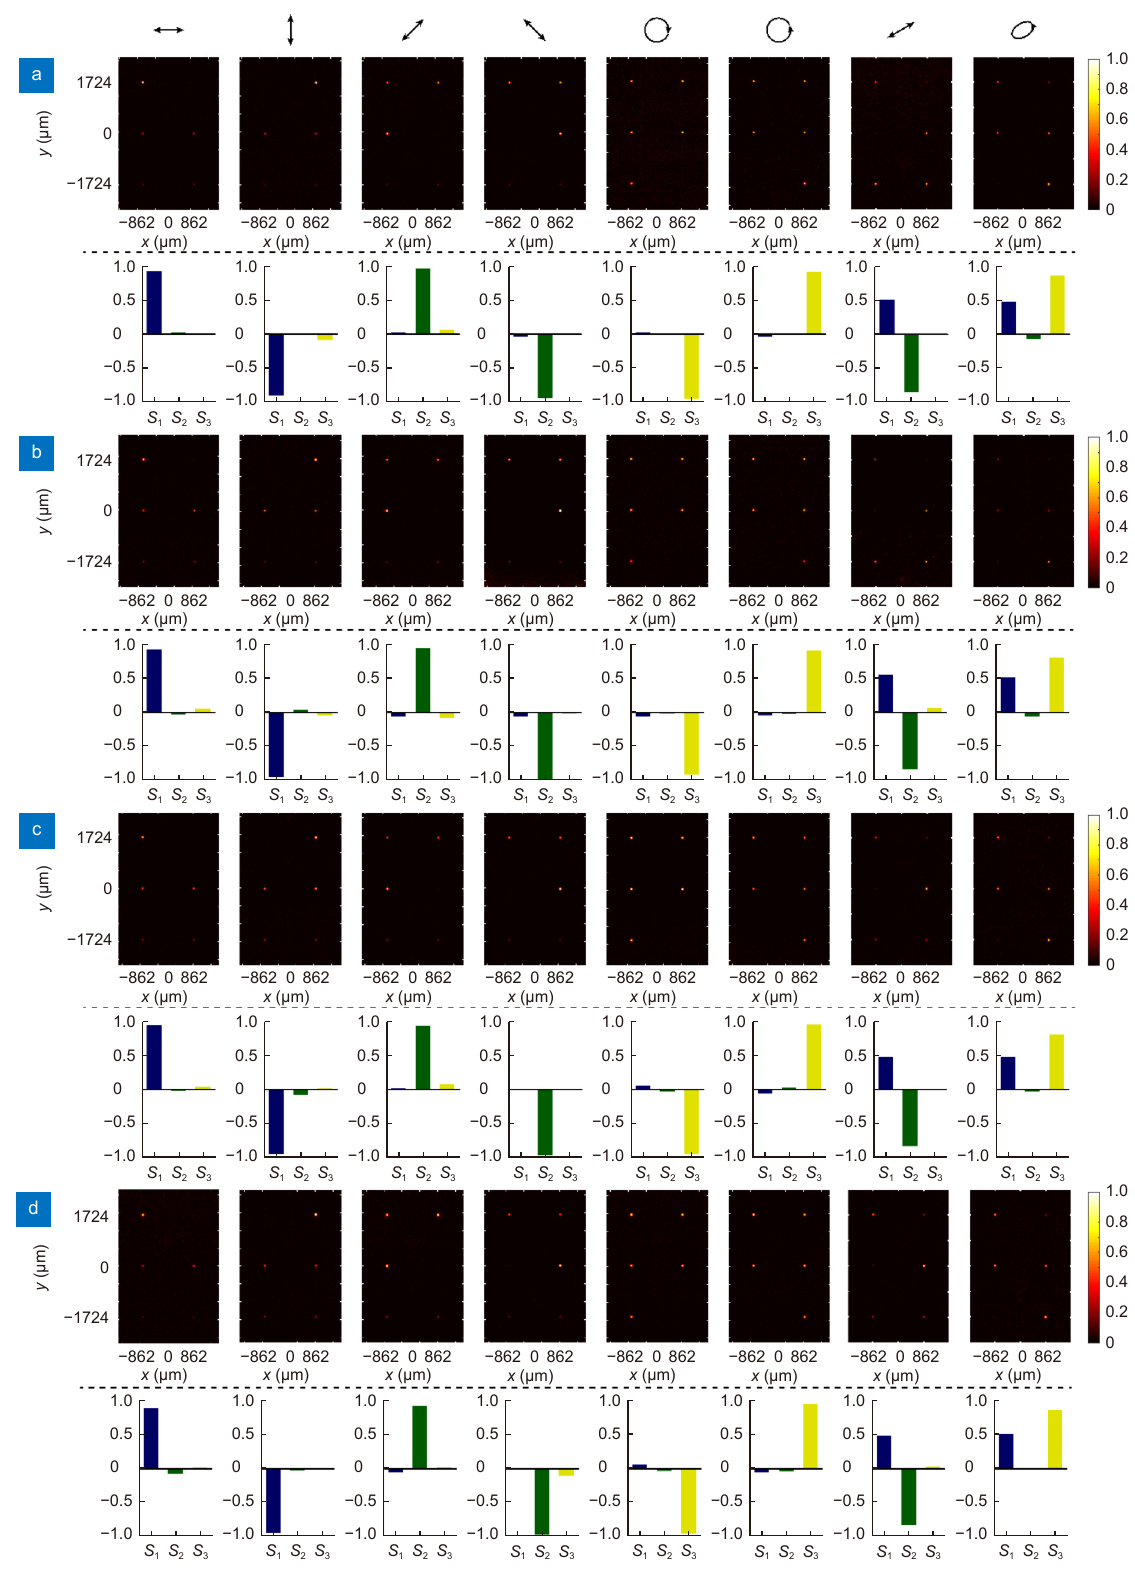
Fig. 6 | Characterization results of the polarimeter. Measured intensity distributions at the focal plane and normalized Stokes parameters for different incident polarizations (shown with black arrows) with wavelengths of ( a ) 9.3 μm, ( b ) 9.6 μm, ( c ) 10.3 μm, and ( d ) 10.6 μm. The theoretic- ally normalized Stokes parameters for X, Y, A, B, L, R, 30º linear polarization and elliptically polarization (the ratio of the major axis to the minor axis is , and the phase difference is 90º) are (1,0, 0), (–1, 0, 0), (0, 1, 0), (0, –1, 0), (0, 0, 1), (0, 0, –1), (0.5, 0.866, 0) and (0.5, 0,